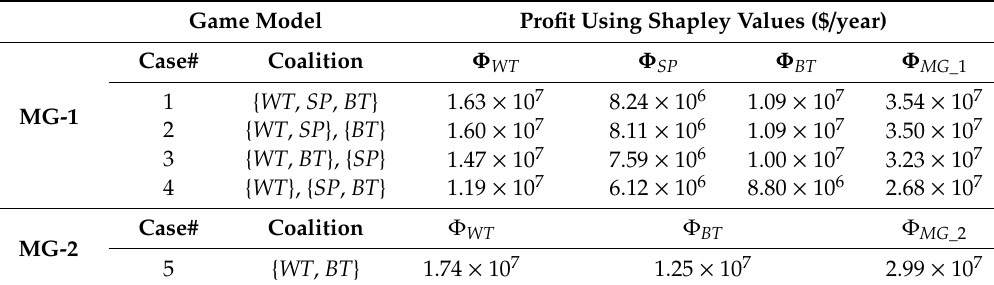
Table 3. Shapley values result for networked microgrid. Table 4. Sensitivity analysis of networked microgrid for game theory techniques.